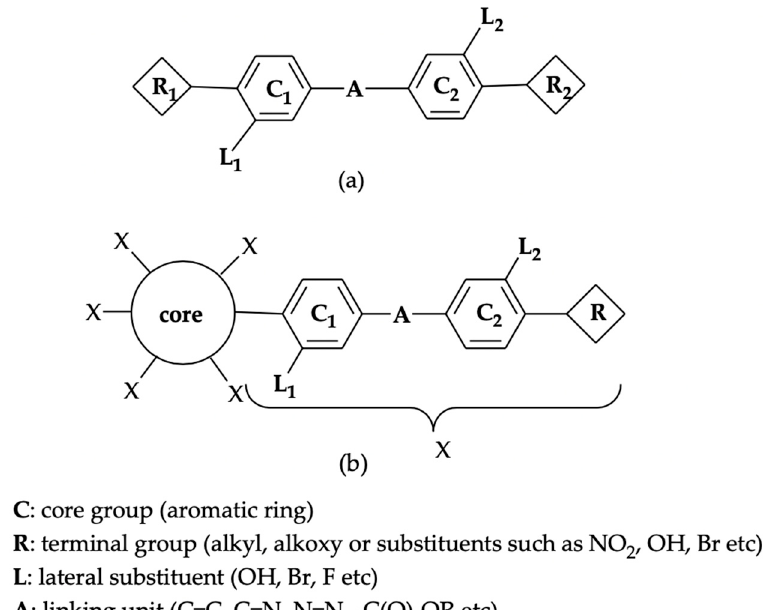
Figure 1. General structure of ( a ) calamitic and ( b ) discotic LC molecules.